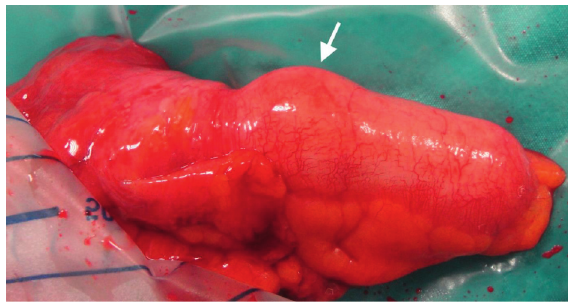
Figure 4: Marked area with suspicion of a mass in the appen- dectomy